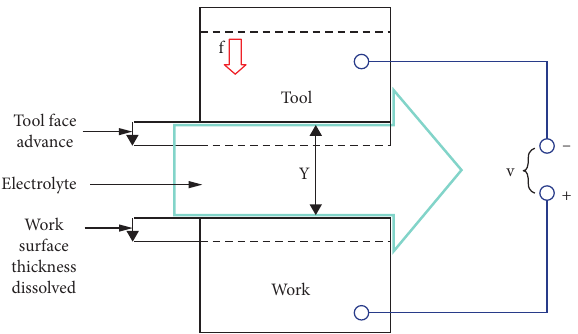
Figure 3: Mechanism of ECM